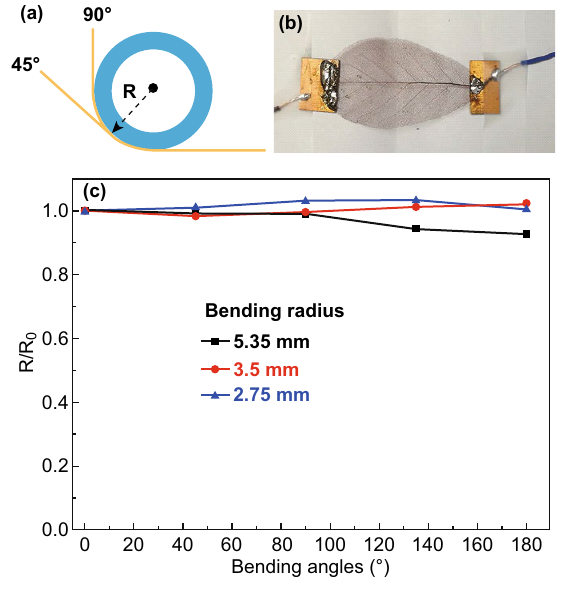
Fig. 5 The image a illustrates the experimental set‑up of the bending tests and b is a photograph of the sample soldered between two pieces of circuit boards and fixed on a piece of paper as mechanical support. c shows the normalized resistance (to the value measured at the bend‑ ing angle of 0°) of a copper‑plated MLLV measured during bending tests with different bending radii and